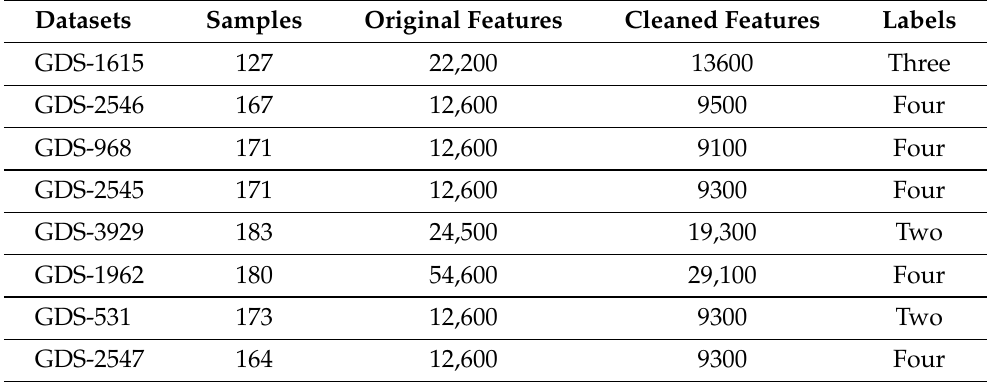
Table 1. Description of the dataset used for the